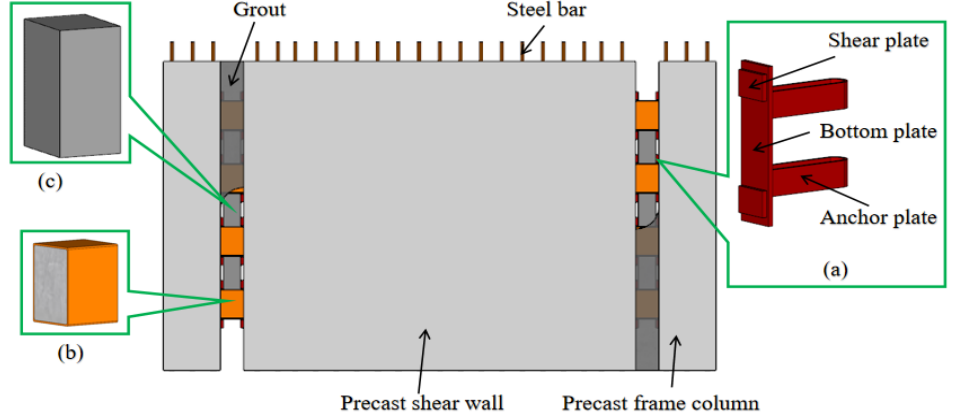
Figure 1. Frame – shear wall structure showing the wall and columns connected by RCFSTKs. ( a ) Embedded part; ( b ) RCFSTKs; ( c ) Plain concrete block.